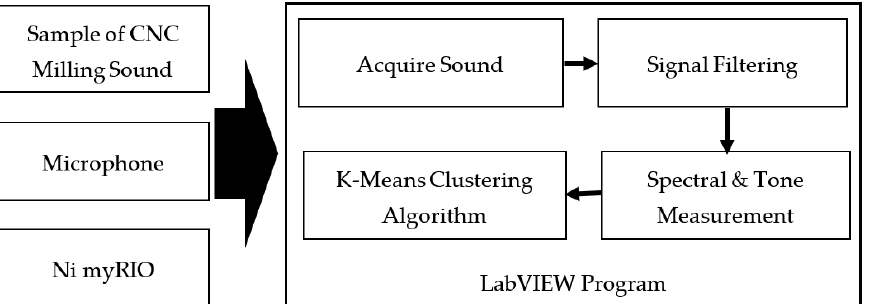
Figure 1. Block diagram of sound detection.